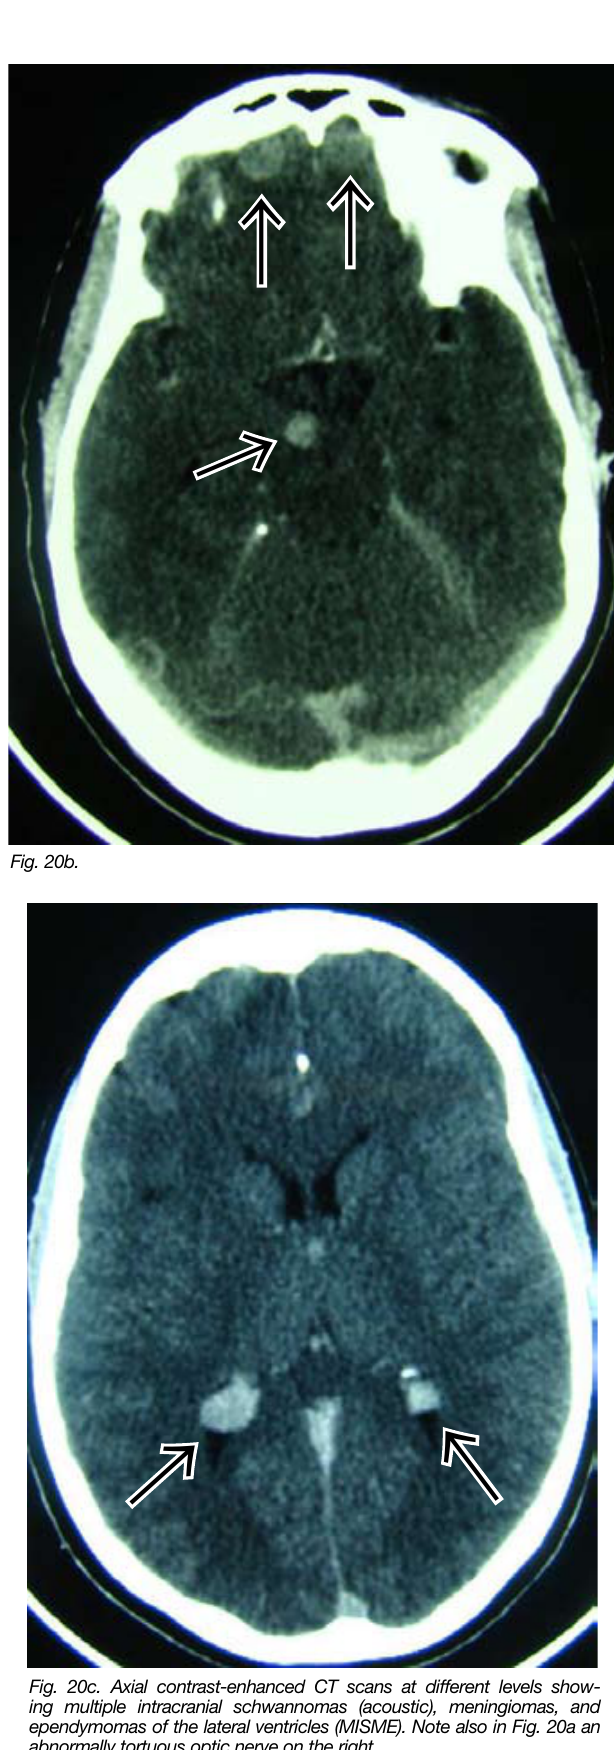
Fig. 20c. Axial contrast-enhanced CT scans at different levels show- ing multiple intracranial schwannomas (acoustic), meningiomas, and ependymomas of the lateral ventricles (MISME). Note also in Fig. 20a an abnormally tortuous optic nerve on the